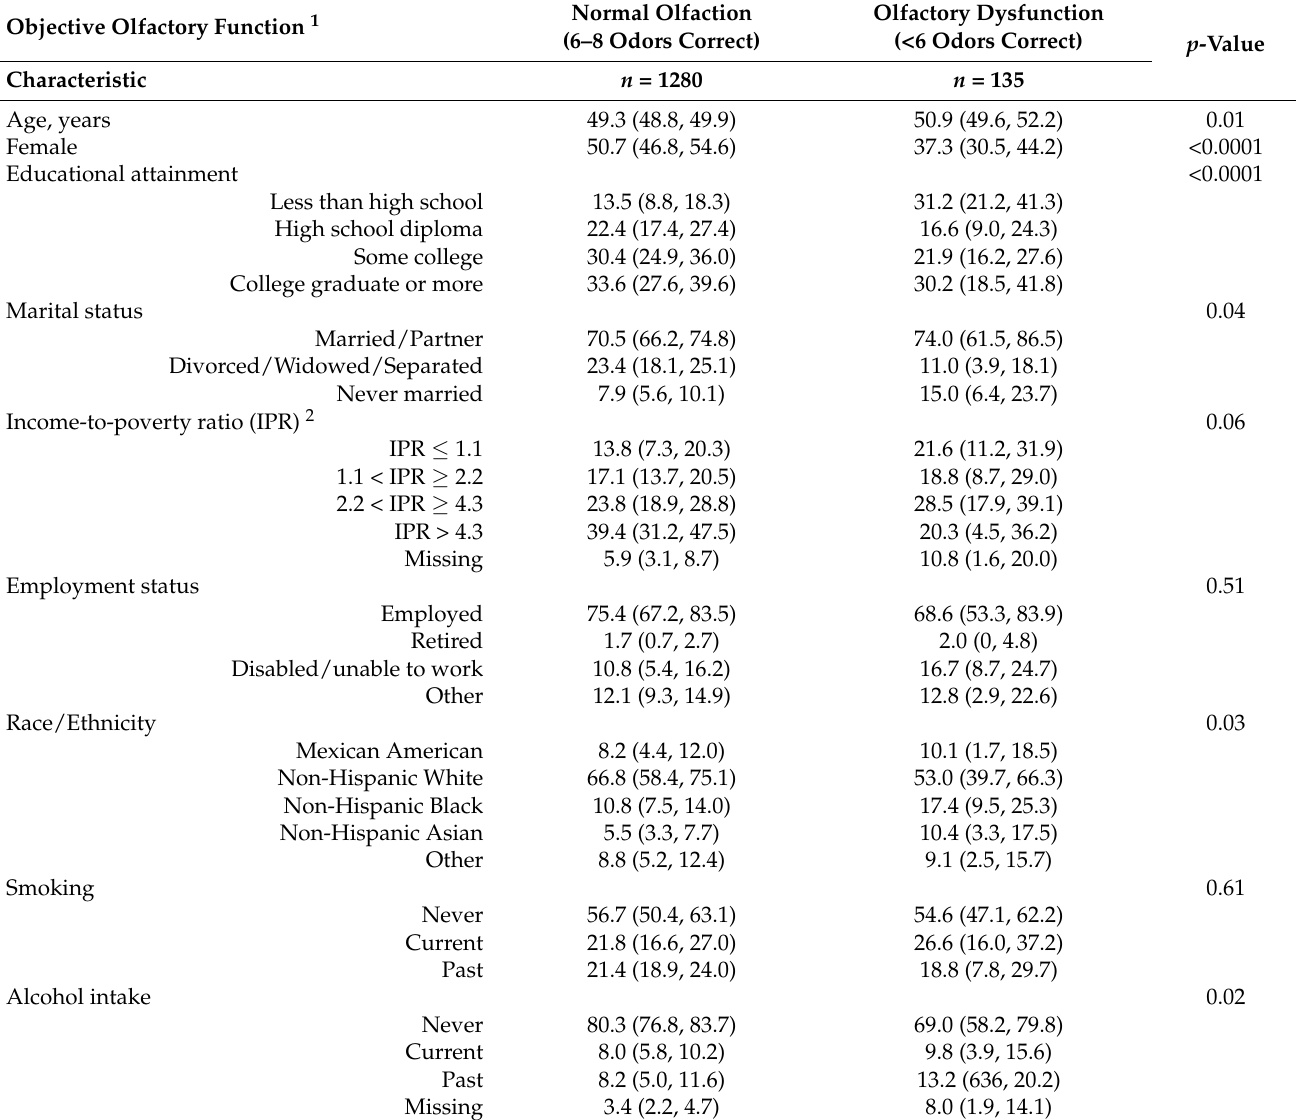
Table 1. Weighted characteristics by objective olfactory function among U.S. adults > 40 years in NHANES